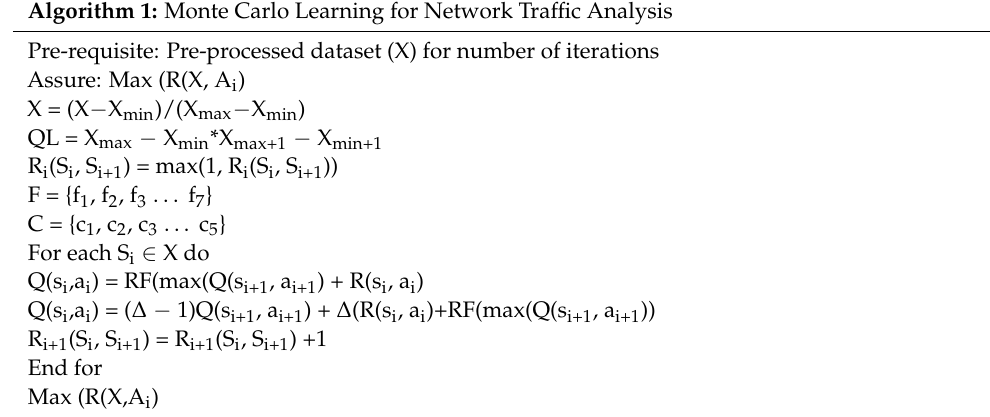
Algorithm 1: Monte Carlo Learning for Network Traffic Analysis